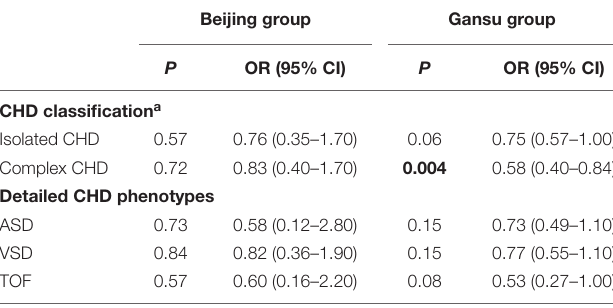
TABLE 3 | Stratified analysis of rs492554 by CHD subtypes in the dominant model (CT + TT vs. CC). Beijing group Gansu group